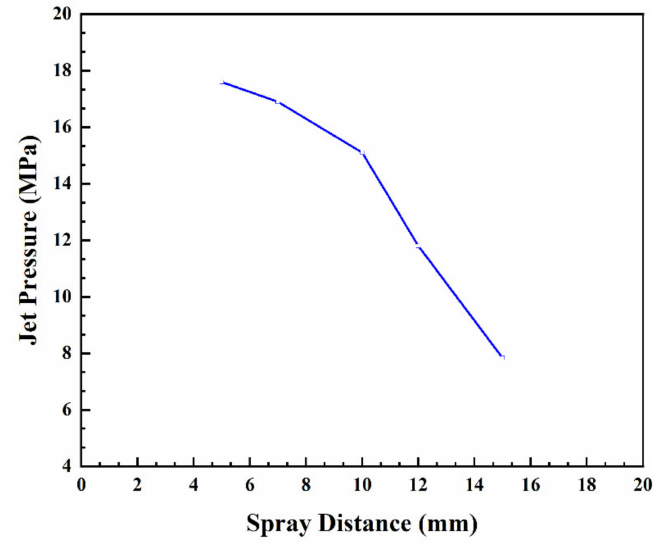
Figure 18. Variation in jet pressure at the well wall under different spray